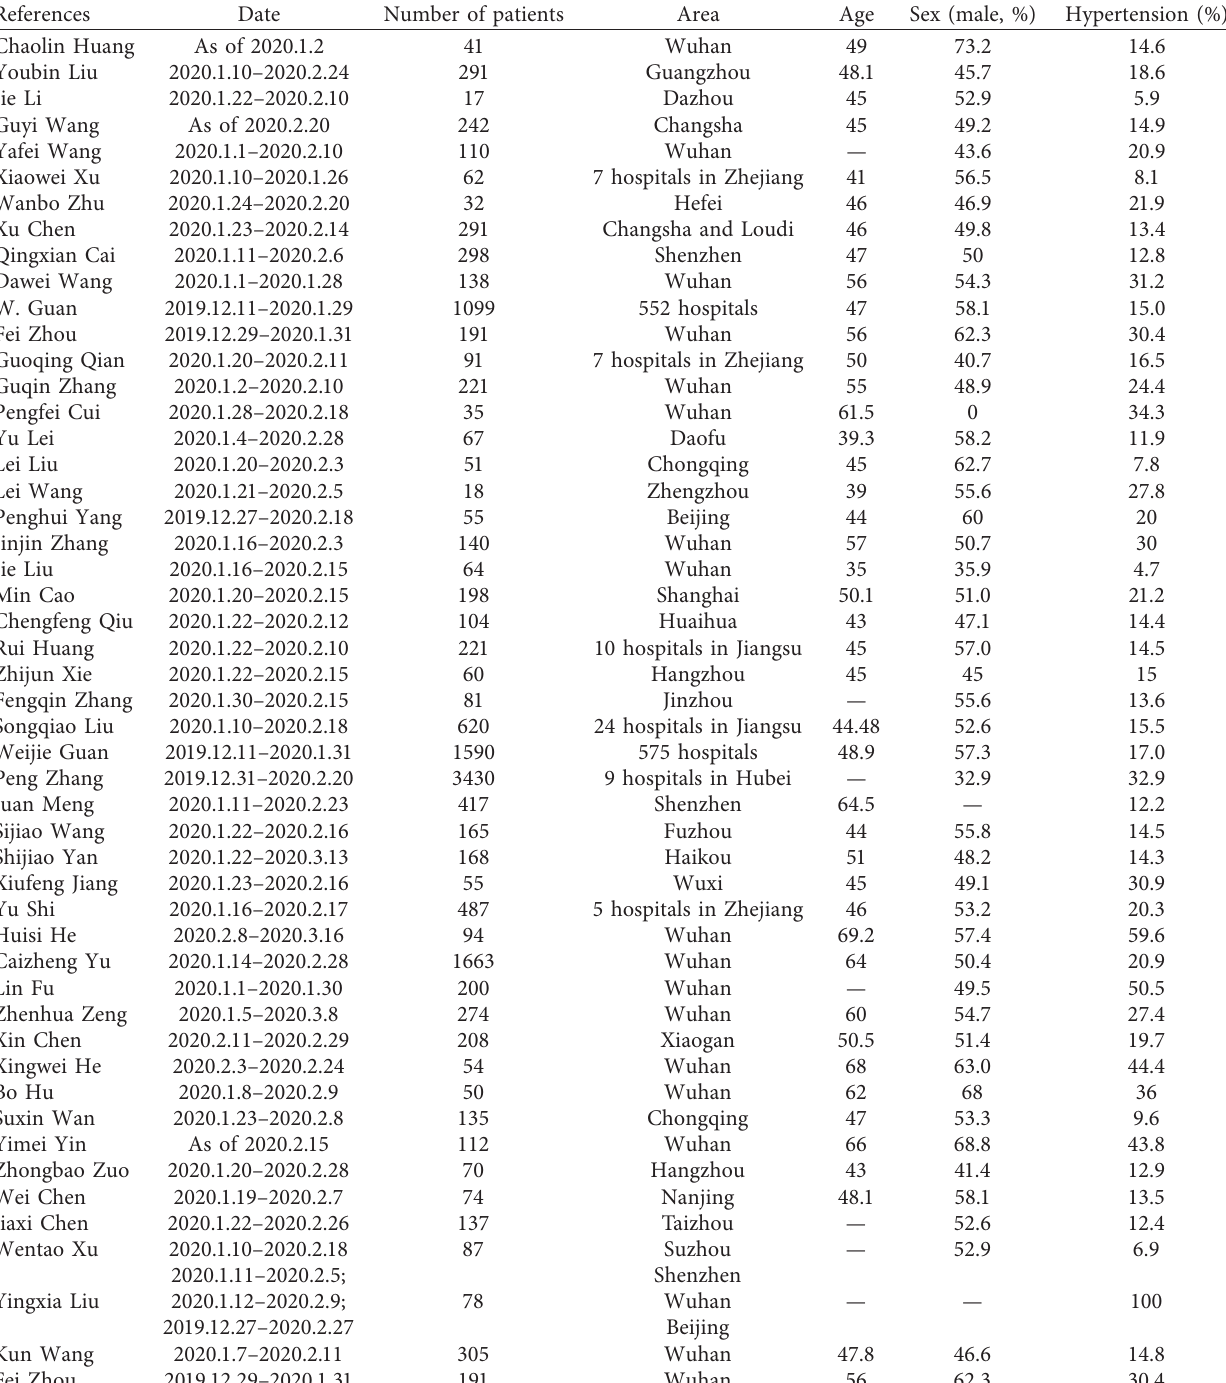
Table 1: Number, age, sex, and hypertension of patients of the included